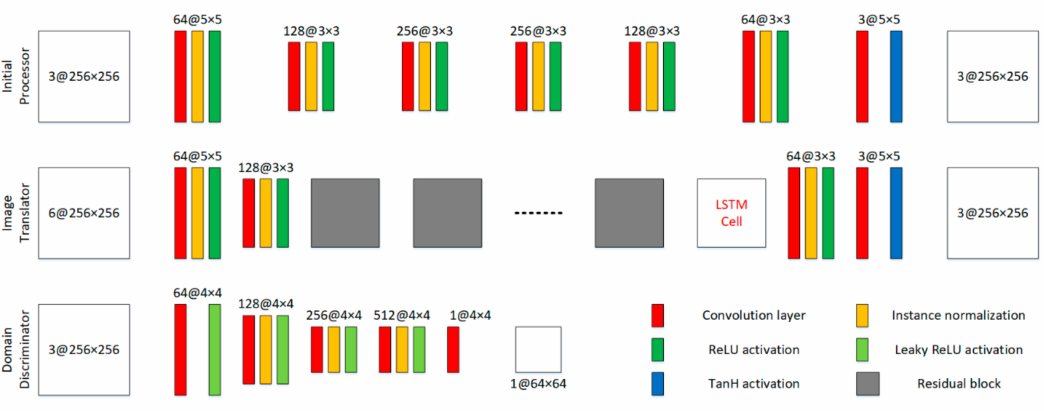
Figure 5. Network architectures of the initial processor, image translator, and domain